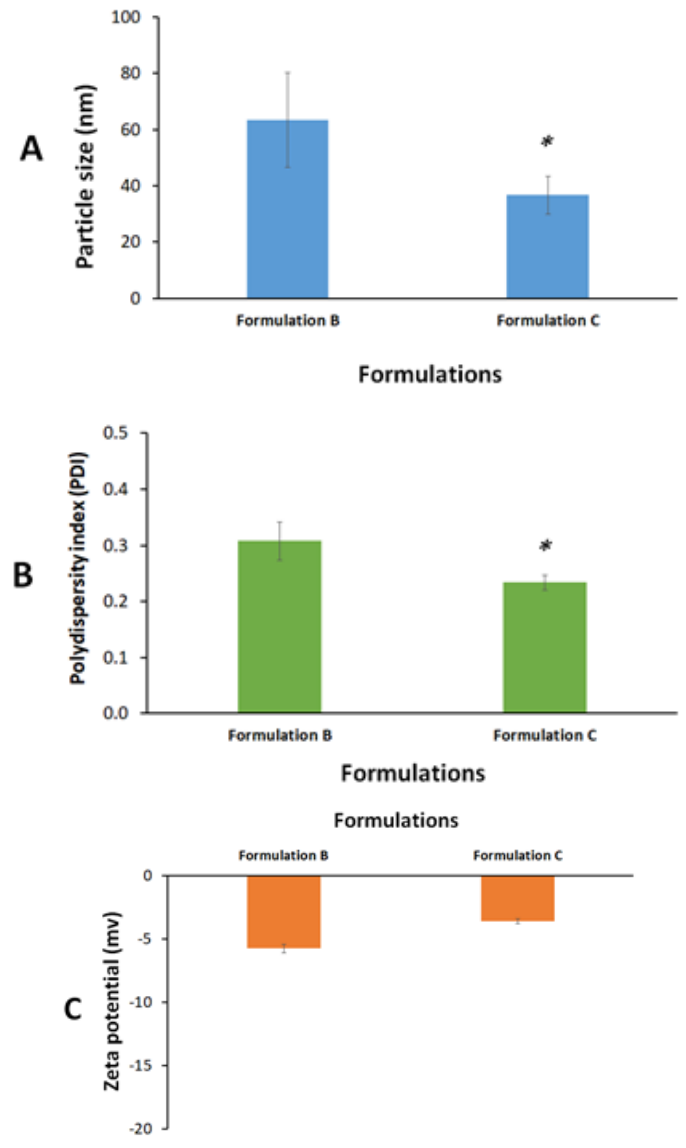
Figure 2. Graphical representations of ( A ) particle size, ( B ) polydispersity index, and ( C ) zeta potential of the diluted formulations. Data were expressed as mean ± SE. * denotes significant difference ( p < 0.05) between the formulations.